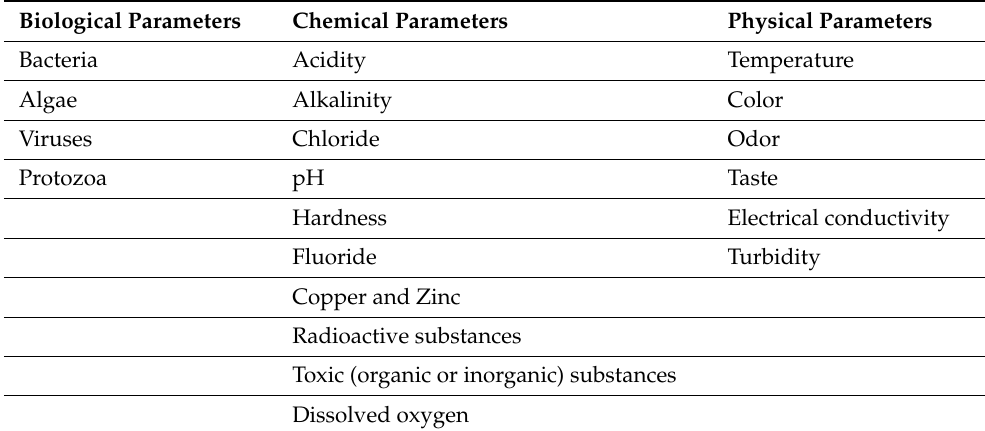
Table 3. Types of water quality